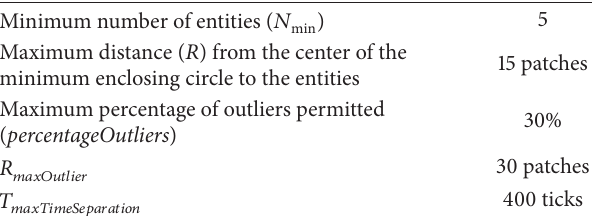
Table 5: Parameters for circular formation detection in NetLogo.